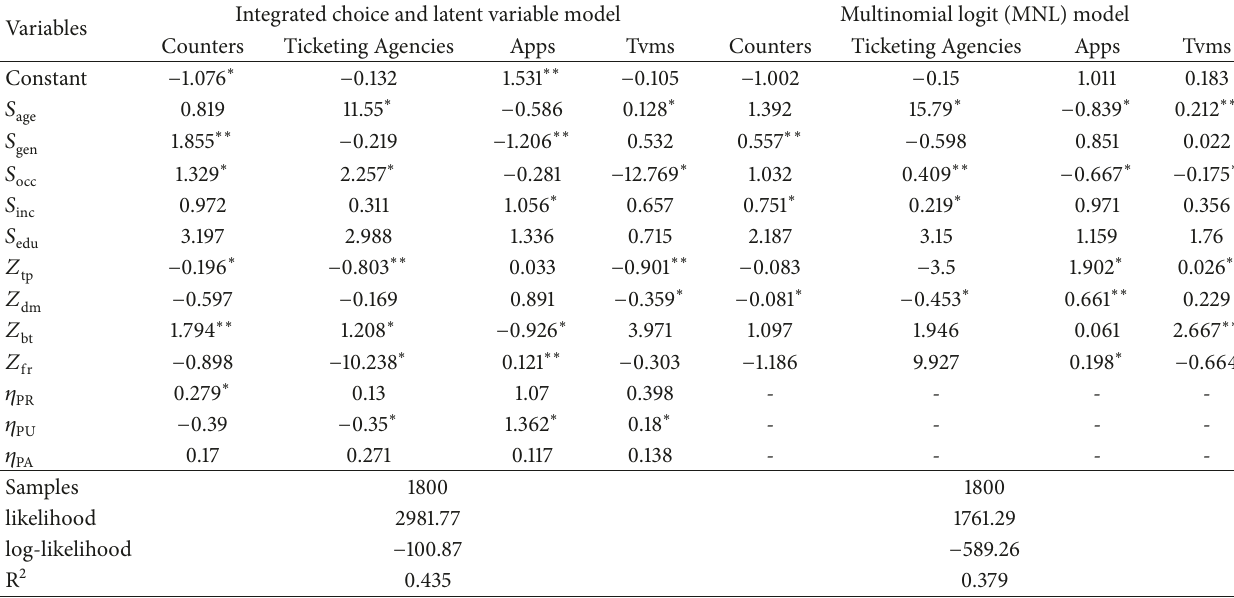
Table 7: Comparison of the estimation